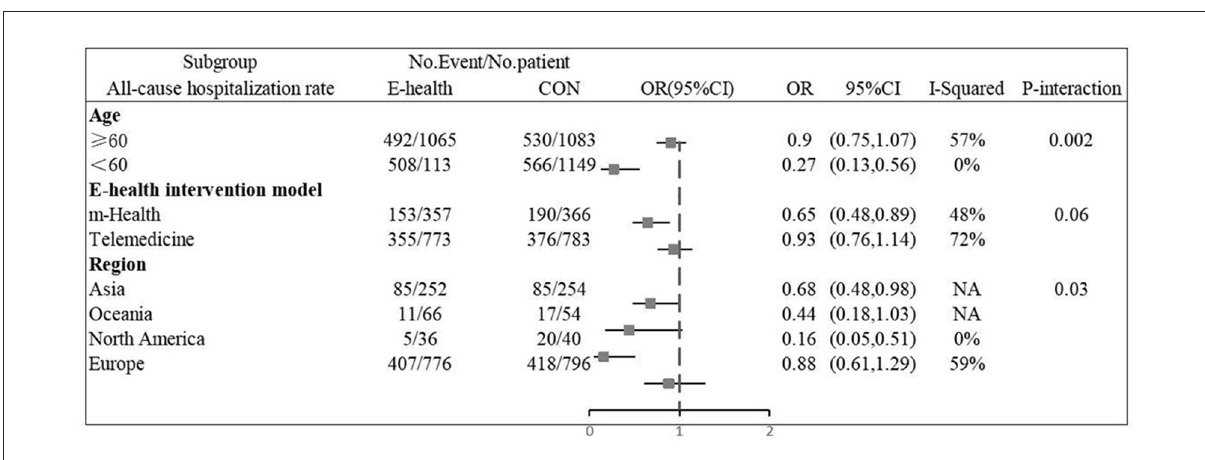
FIGURE7 Subgroup analysis for outcome of all-cause hospitalization